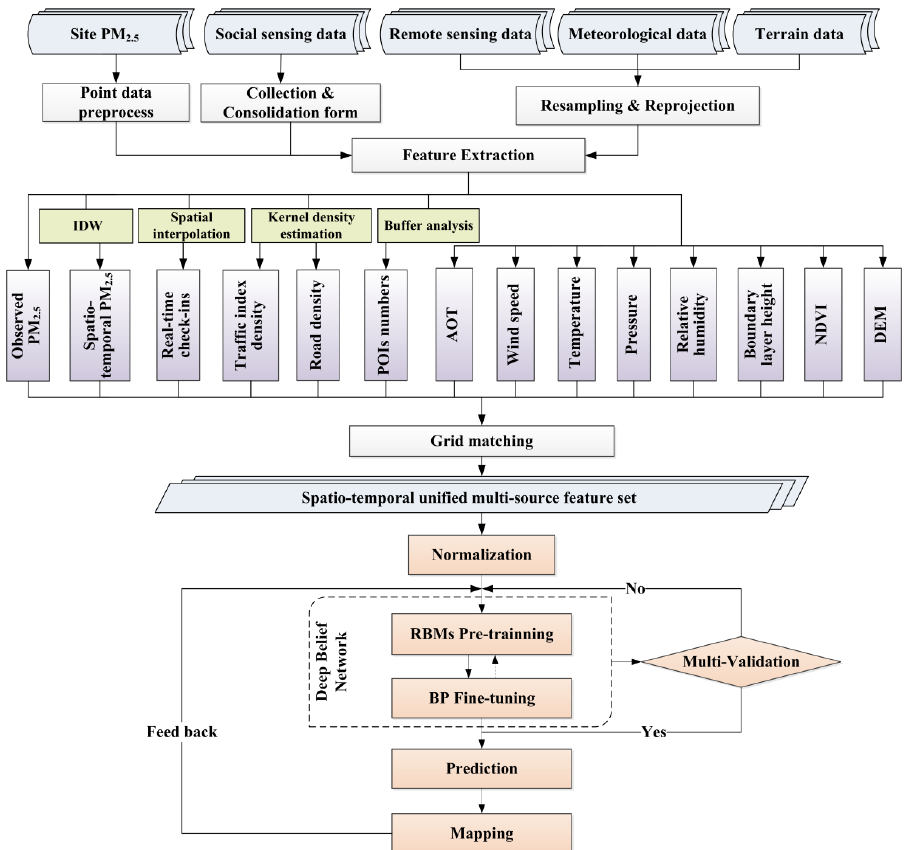
Figure 2. Data and modeling processes. “IDW” means inverse distance weighting method; “POI” means points of interest; “AOT” means aerosol optical thickness product; “NDVI” means normalized di ff erence vegetation index product; “DEM” means digital elevation model data; “RBM” means restricted Boltzmann machine; “BP” means the back-propagation neural